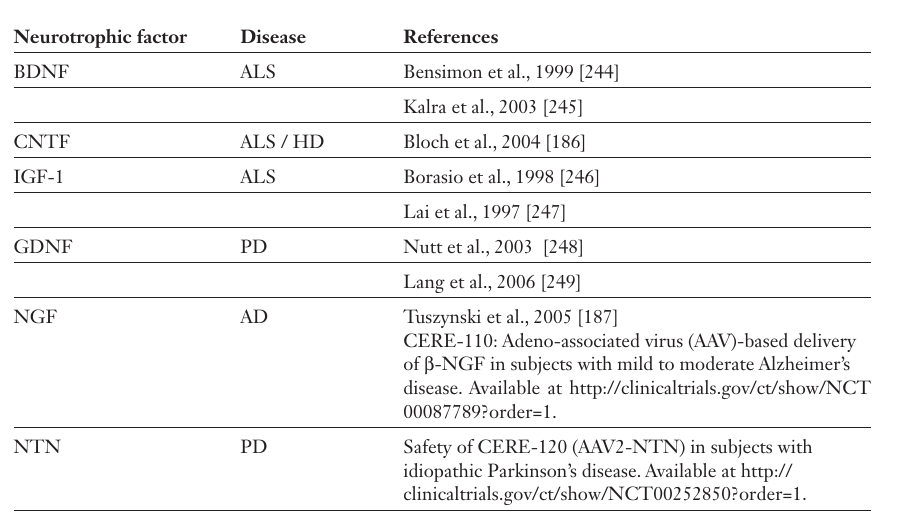
Neurotrophic factors in clinical